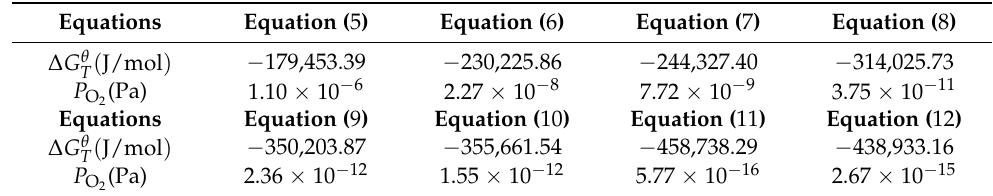
and P O of the Equation (4) to Equation (11). T 2